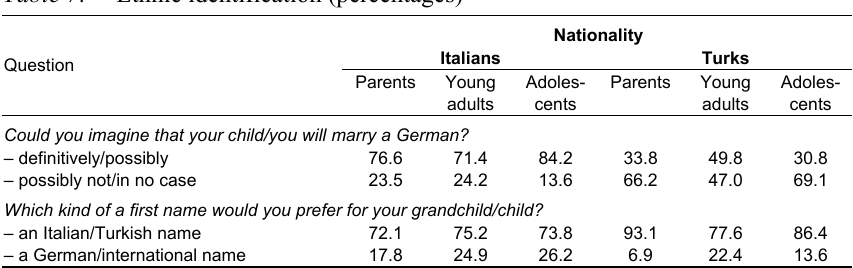
Table 7: Ethnic identification (percentages)